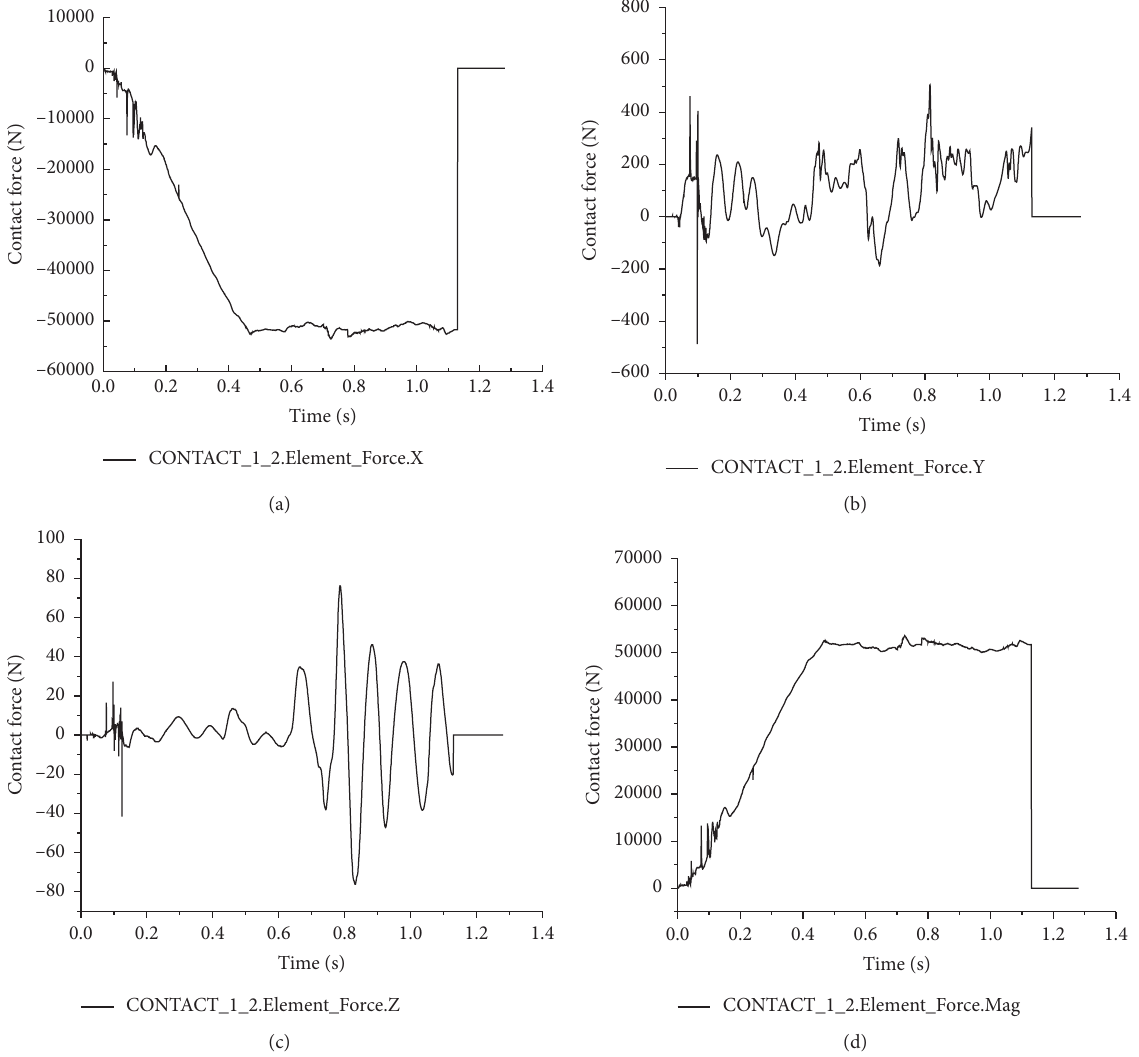
Figure 19: Contact force change between links at the chain rupture position. (a) Contact force in the X direction. (b) Contact force in the Y direction. (c) Contact force in the Z direction. (d) Contact force